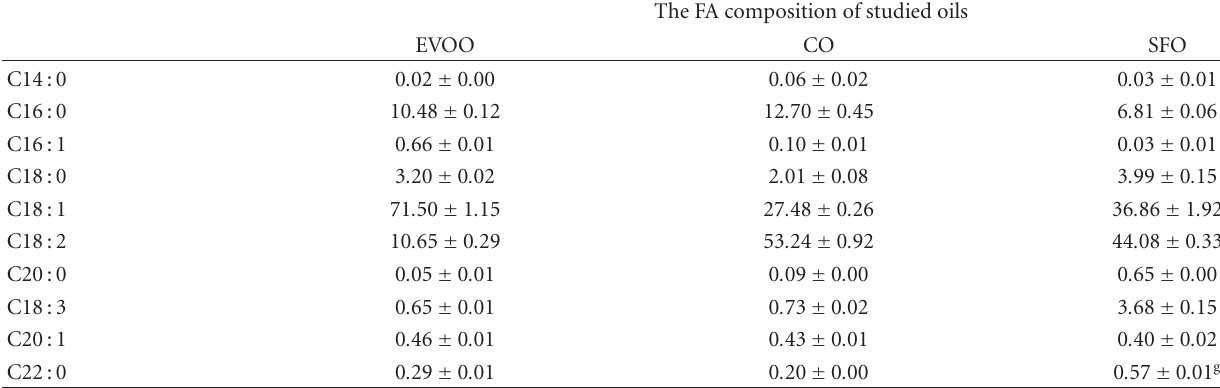
Table 1: FA composition of olive, corn, and sunflower oils. The FA composition of studied oils